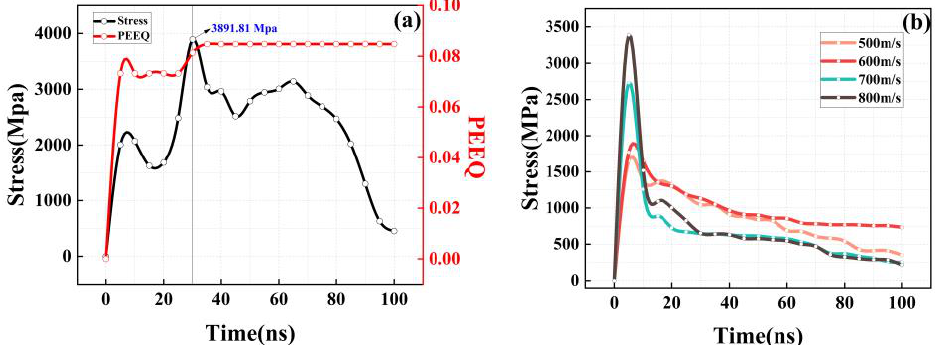
Figure 8. Impact simulation of single-particle basalt fiber; ( a ) single-particle impact of Al–basalt fiber; ( b ) single-particle impact of basalt fiber under the velocities of 500, 600, 700, and 800 m/s.